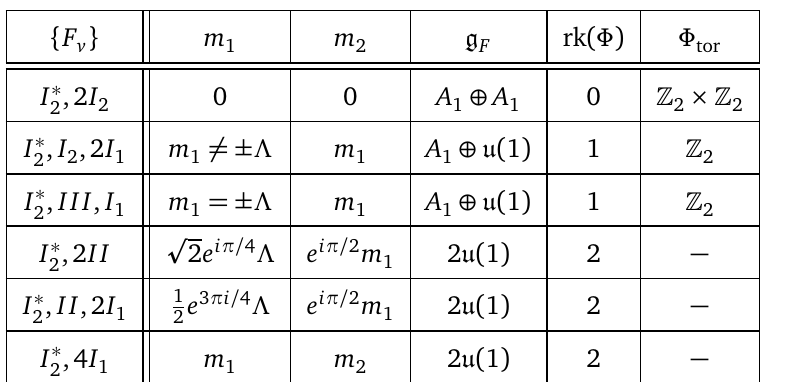
Figure 7: Fundamental domain for Γ 0 ( 3 ) corresponding to the configuration ( I ∗ , I , I I ) on the CB of the 4d SU ( 2 ) , N 1 3 is the elliptic point of the congruence subgroup Γ 0 ( 3 )